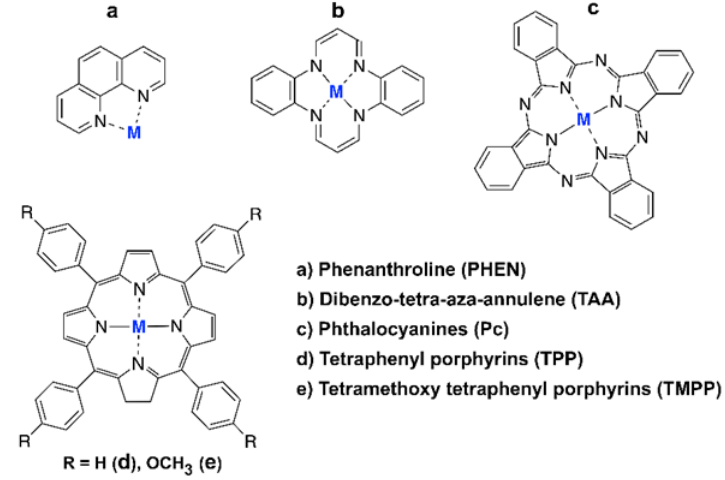
Figure 11. Molecular structures of some the most investigated macrocycles as NPM catalysts. M stands for Mn, Fe, Ni, Co or Cu.